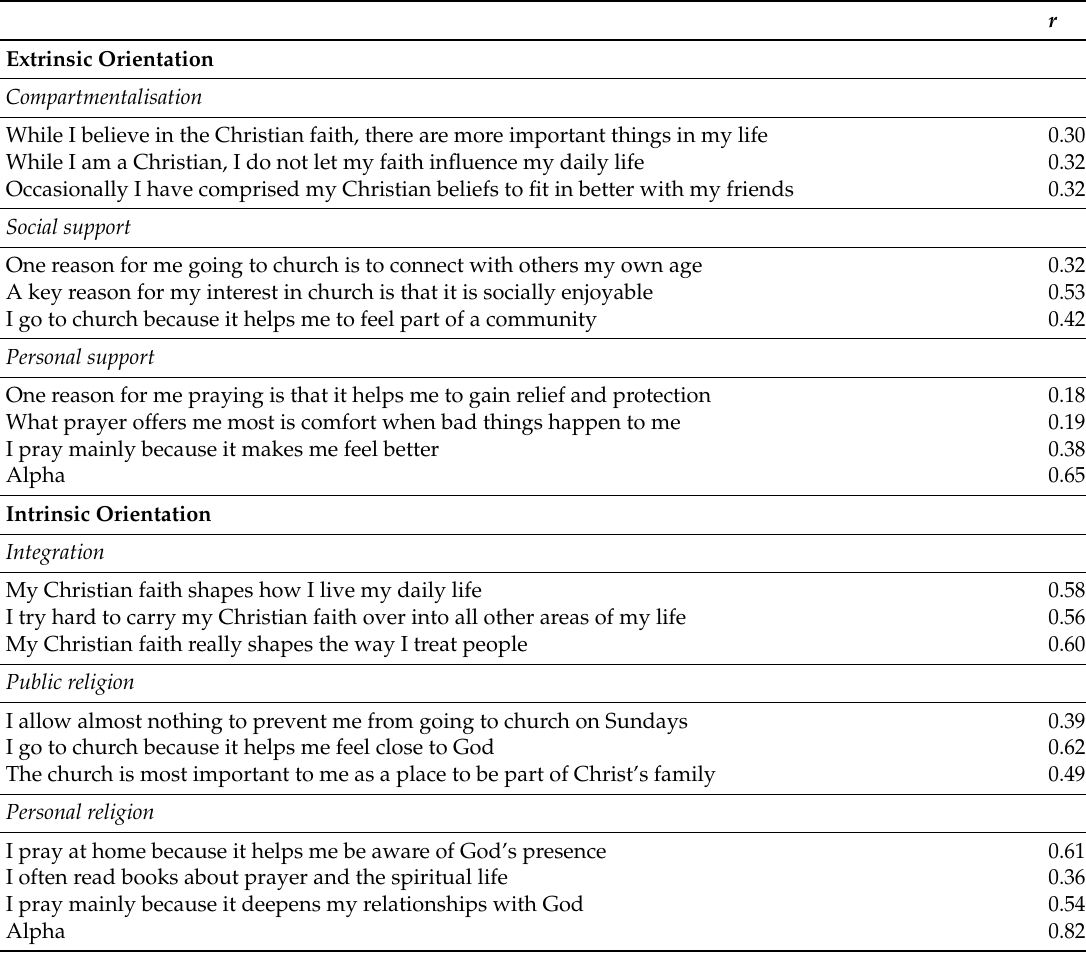
Table 1. New Indices of Religious Orientation